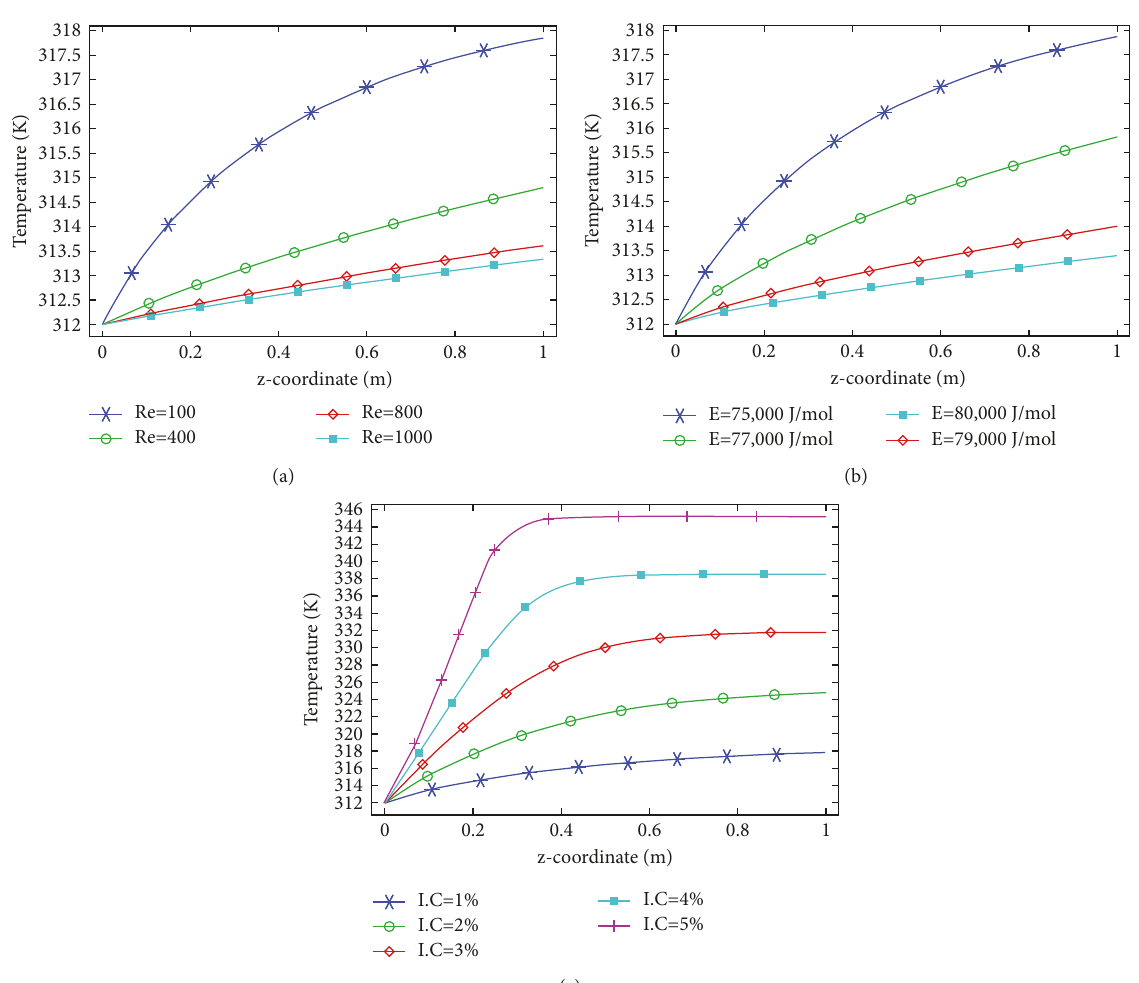
Figure 8: Temperature distribution along the length of the channel: (a) I.C � 1%, E � 75,000J/mol; (b) I.C � 1%, Re � 100; (c) Re � 100, E �